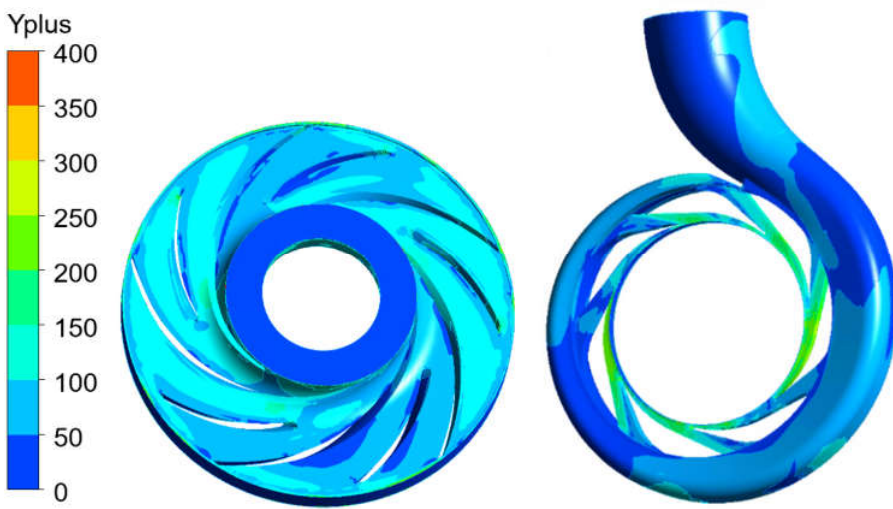
Figure 3. y + values of the impeller and the area of the volute.